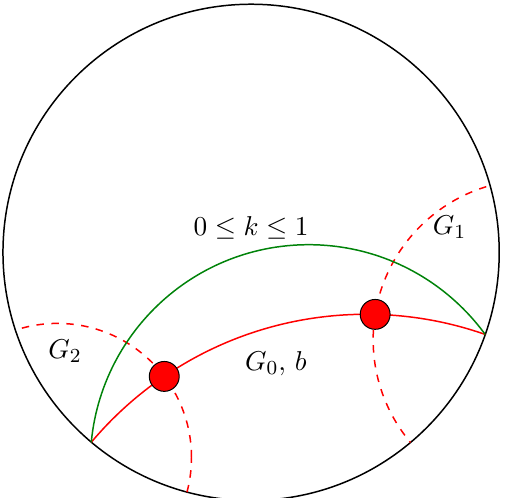
Figure 3 . Figure showing a region of a trumpet which ends on a single geodesic boundary G 0 of length b . The red curves represent geodesics on the Poincaré disk and the two geodesics G G 2 which are dotted are identified ( G 1 = G 2 ). In order to be able to identify such two